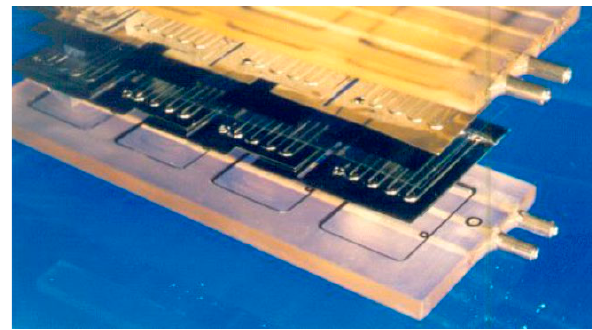
Figure 17. Micro-fuel cell by Fraunise ISE for mobile phone. Cour- tesy of Fuel Cells